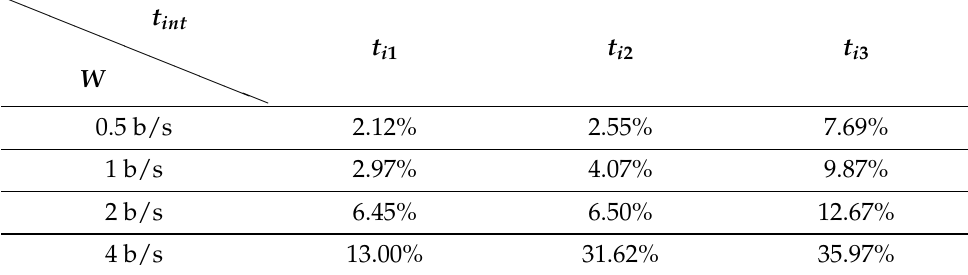
Table 1. Bit error rate determined for the amplitude analysis method.